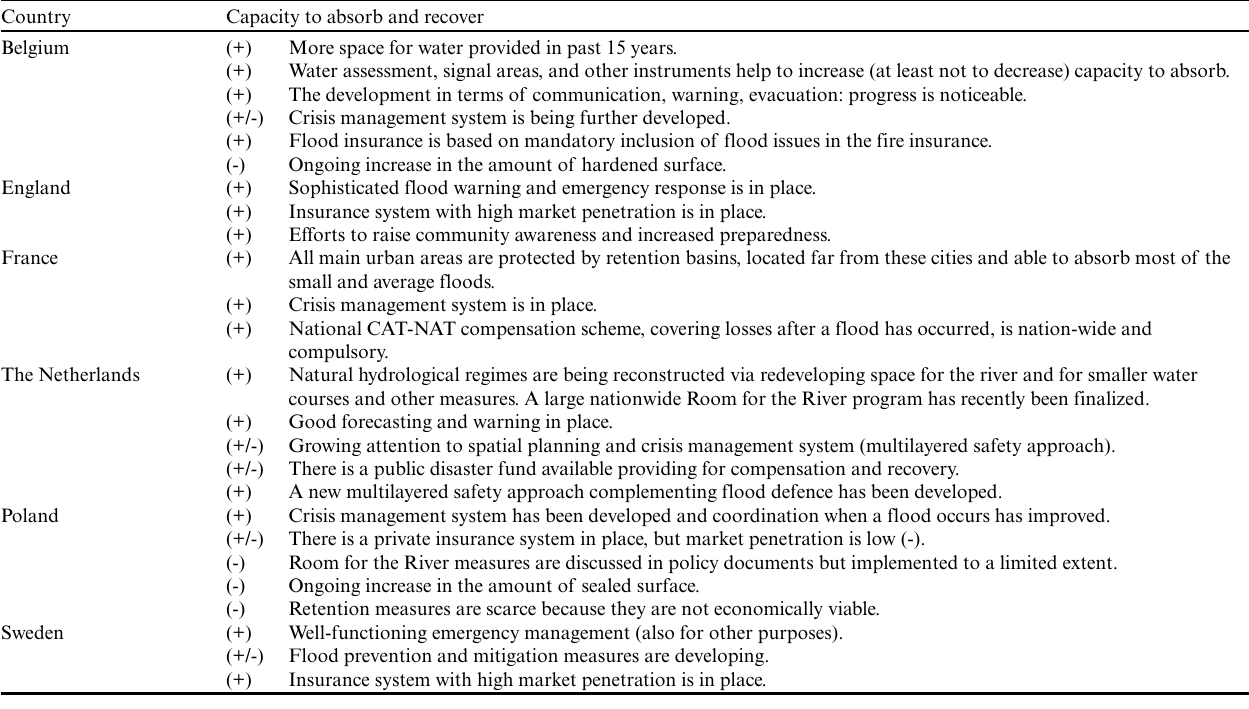
Table 5 . Capacity to absorb and recover in the six evaluated countries.